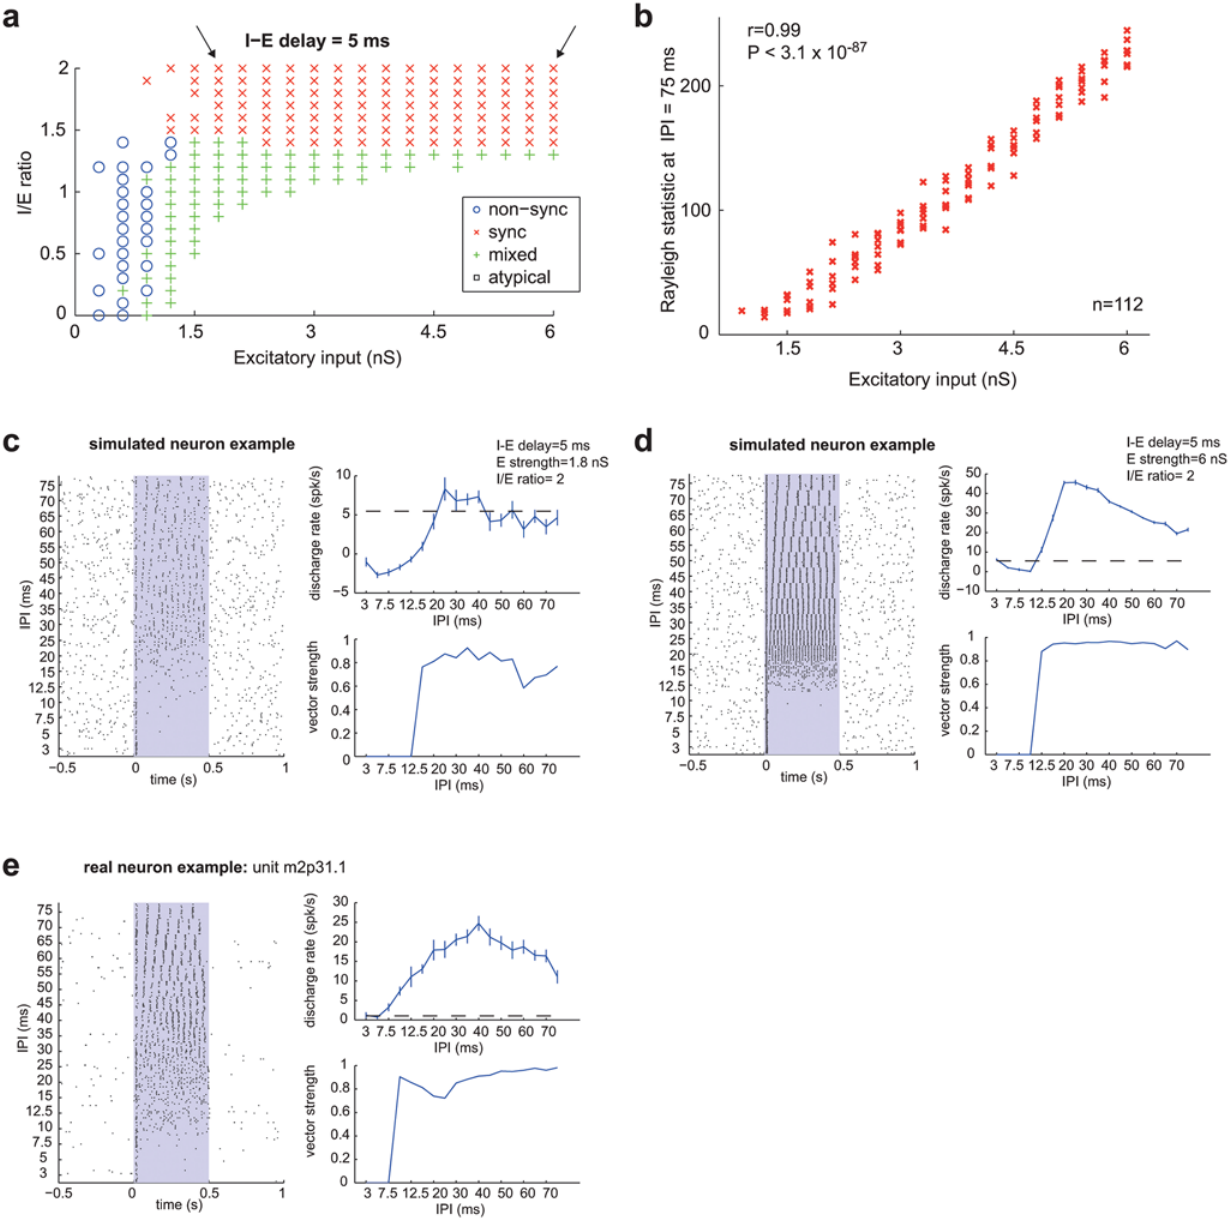
Fig 4. Simulated synchronized neuron. a. Classification of neuron-type [non-sync (o), sync (x), mixed (+), atypical (square)] across two parameters (Excitatory input and I/E ratio), with a fixed I-E delay of 5 ms. The two arrows indicate the parameters used for the simulated neurons in Fig. 4c (left arrow) and Fig. 4d (right arrow). b. Dependence of Rayleigh statistic (at an IPI of 75 ms) on the amplitude of excitatory inputs in simulated synchronized neurons. Spearman correlation coefficient: r = 0.99, P < 3.1x10 -87 . c-e. Examples of simulated and real synchronized neurons. Each plot is subdivided into a raster plot (left), IPI vs discharge rate plot (top right), and IPI vs vector strength plot (bottom right). The stimulus is played for 500 ms, which is indicated with the gray rectangle in the raster plot. The dashed line in the IPI vs discharge rate plot indicates a significant evoked response above the spontaneous rate (2 σ ). Error bars indicate SEM. c. Simulated neuron: I-E delay = 5 ms, E strength = 1.8 nS, I/E ratio = 2. d. Simulated neuron: I-E delay = 5 ms, E strength = 6 nS, I/E ratio = 2. e. Real neuron (unit m2p31.1) from awake marmoset auditory cortex.